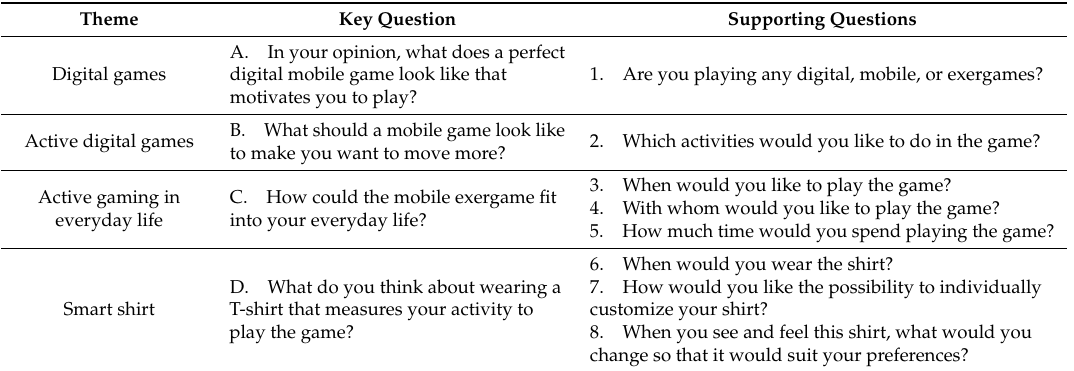
Table 3. Semi-structured focus group guide for